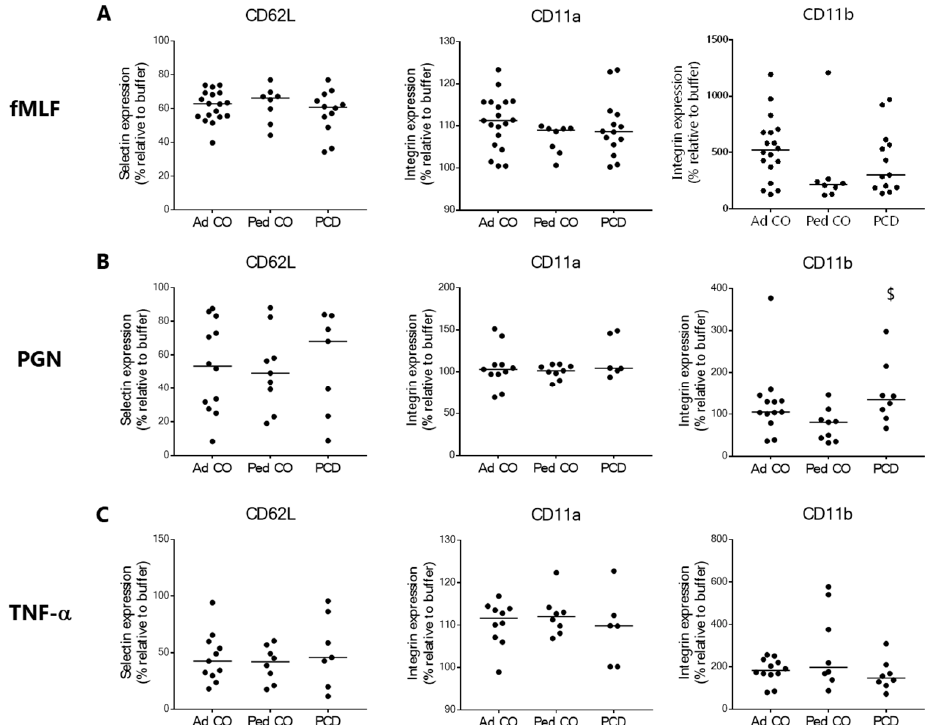
Figure 4. Circulating PMNs from patients with PCD show similar expression levels of adhesion molecules compared to PMNs from healthy controls upon pro-inflammatory stimulation. The differential expression of the selectin CD62L and integrins CD11a and CD11b upon stimulation with ( A ) fMLF (10 − 8 M), ( B ) PGN (10 µ g/mL) and ( C ) TNF- α (50 ng/mL) on PMNs from patients with PCD (PCD, n = 6–14 [6–14 pediatric and 0–3 adult]), age-matched healthy pediatric controls (Ped CO, n = 8–9) and healthy adult controls (Ad CO, n = 10–19) was measured by flow cytometry. The expression levels were normalized to the expression level without stimulation (i.e., buffer treatment). Statistical differences were determined by the Mann Whitney U-test (Ped CO versus PCD: $ p < 0.05).